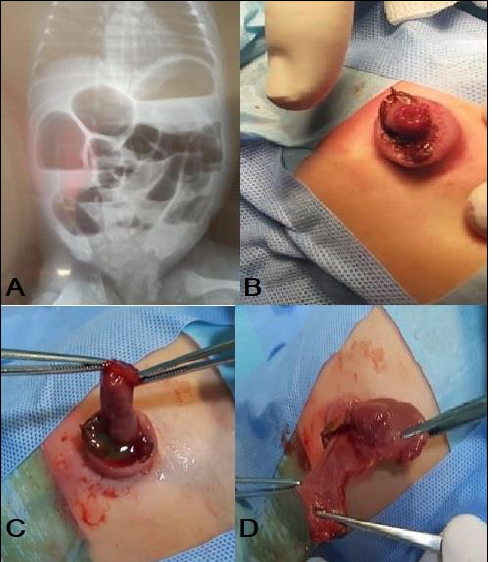
Figure 3: A) Crushed hernia of the umbilical cord. Clamp has been removed. B) Contents of the hernia of the umbilical cord. Arrowhead shows umbilical ring. C) Umbilicoplasty.